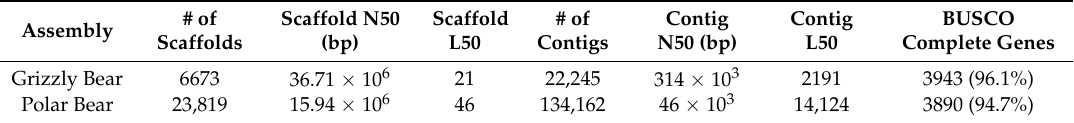
Table 2. Assembly statistics of the grizzly bear and its closest sequenced relative, the polar